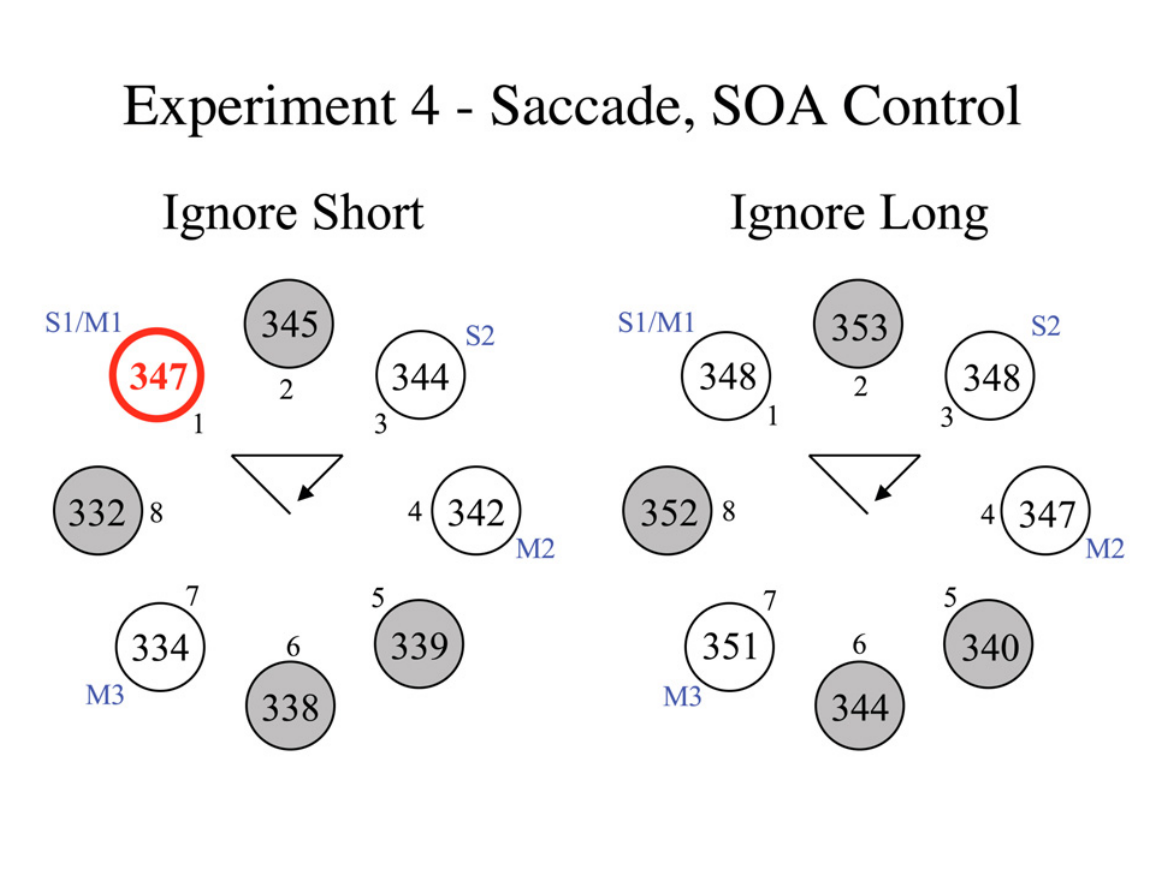
FIGURE 7. Mean of median saccadic RT in the Ignore Short and Ignore Long conditions of Experiment 4. Formatting is the same as in Fig.